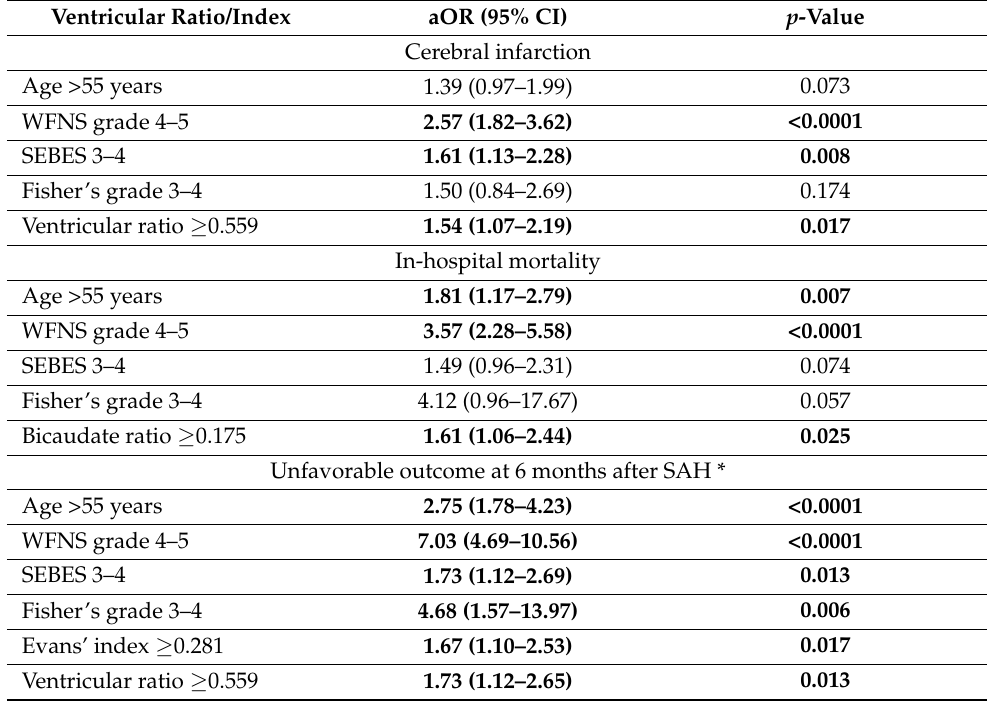
Abbreviations: aOR = adjusted odds ratio; CI = confidence interval; AUC = area under the curve; ROC = receiver operating characteristic. SEBES = subarachnoid hemorrhage early brain edema score; WFNS = world federation of neurosurgical societies. * Defined as modified Rankin scale >3. Significant values are in